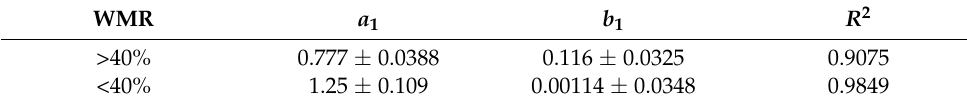
Figure 11. Relationship between WMR and lobetyolin retention rate: ○ represents the data from this work; ● and ■ represent the data from previous work [22]. Reproduced with permission from Pan, J.; Shao, J.; Qu, H.; Gong, X, ethanol precipitation of Codonopsis Radix concentrate with a membrane dispersion micromixer; published by J. Clean. Prod, 2020. Table 3. Linear fitting results for lobetyolin retention rate and WMR.